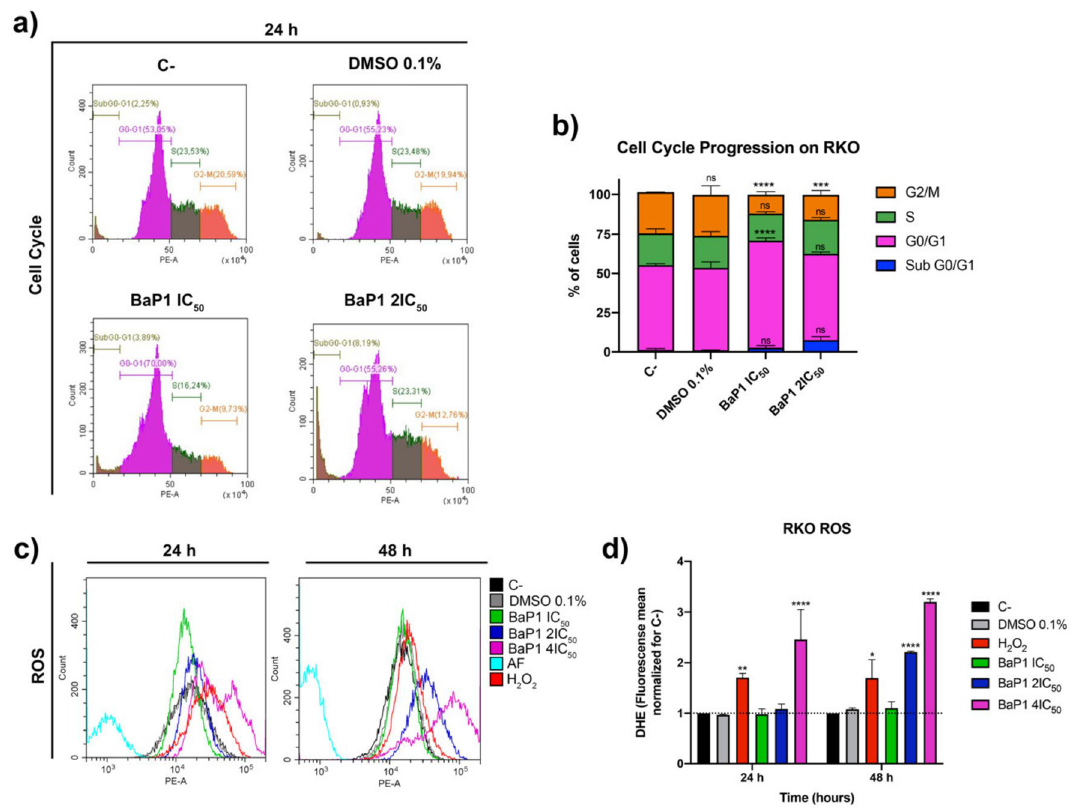
Figure 4. BaP1 effects on RKO cell cycle and reactive oxygen species (ROS) generation. ( a ) Repre- sentative histograms of RKO cell cycle analysis with propidium iodide after 24 h of exposure to BaP1 IC 50 and 2 × IC 50 . Untreated cells (C-) and DMSO (0.1%) exposed cells were used as negative controls. Stage gates were established for C- and transposed for the other conditions. ( b ) Quantifi- cation of the cells in the different stages (G2/M, S, G0/G1, and Sub G0/G1). Values are means with SD (n ≥ 3). Statistical a nalysis was performed by two-way ANOVA. *** p < 0.001, **** p < 0.0001, ns (not significative). ( c ) Representative histograms of ROS generation analysis with dihydroethidium (DHE) after 24 and 48 h of exposure to BaP1 IC 50 , 2 × IC 50, and 4 × IC 50 . Untreated cells (C-) and DMSO (0.1%) exposed cells were used as negative controls and H 2 O 2 (150 μM) as a positive control. ( d ) Quantification of the ROS levels by DHE fluorescence mean; values normalized for C-. Values are means with SD (n ≥ 3). Statistical analysis was performed by two -way ANOVA. * p < 0.05, ** p < 0.01, **** p < 0.0001.